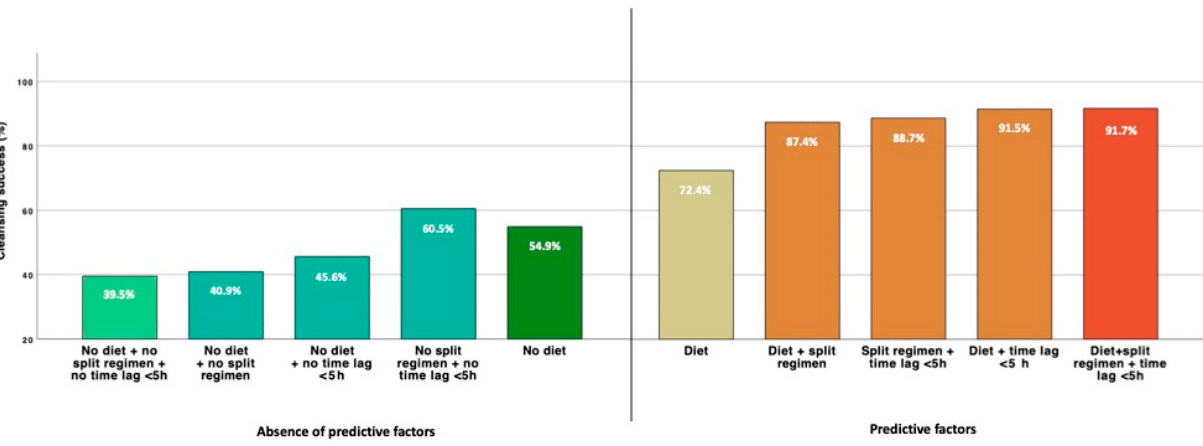
Figure 2. Cleansing success rates in patients ≥ 65 years by combination of different predictive factors. The logistic multiple regression model for HQC of the right colon showed that preparation with 1-L PEG-ASC over 2-L PEG (OR = 2.77, 95% CI = 1.52–5.03; p = 0.001), preparation with 4-L PEG over 2-L PEG (OR = 3.78, 95% CI = 2.03–7.03; p < 0.001), split regimen (OR = 4.58, 95% CI = 2.43–8.64; p < 0.001), and tolerability score (OR = 1.20, 95% CI = 1.05–1.38; p = 0.005) were independently associated with HQC of the right colon in the elderly (Table 3).